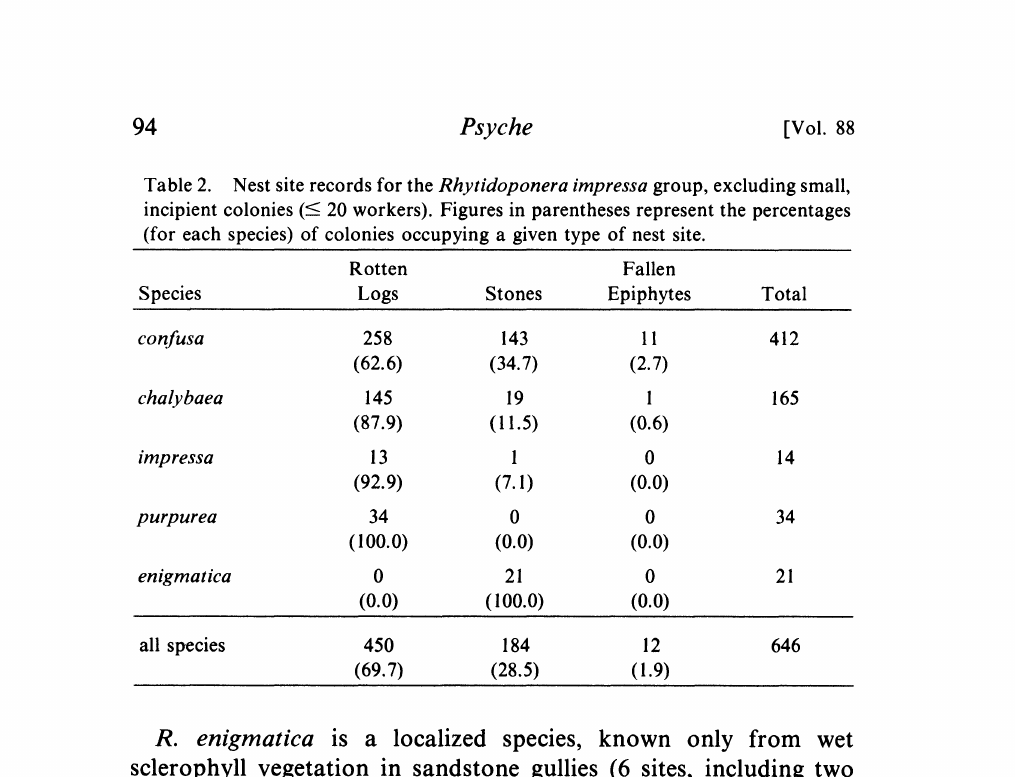
Table 2. Nest site records for the Rhytidoponera impressa group, excluding small, incipient colonies (_< 20 workers). Figures in parentheses represent the percentages (for each species) of colonies occupying a given type of nest